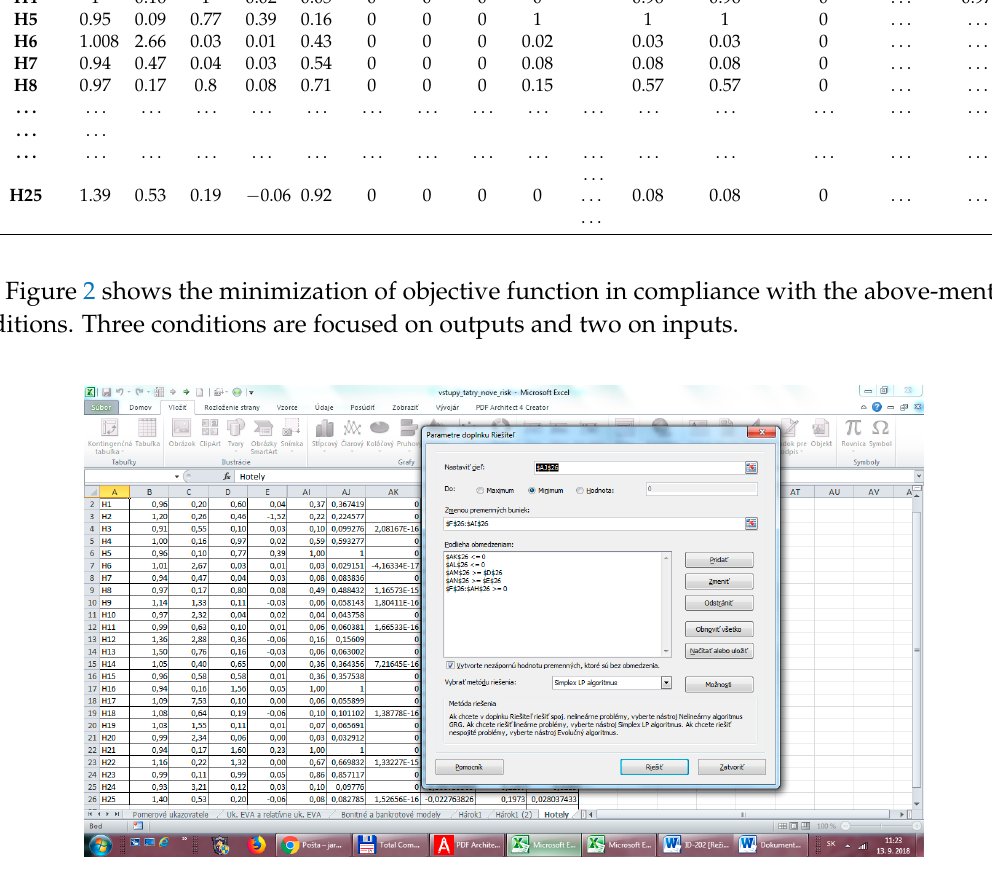
Figure 2. The example of inserting objective function and conditions in Solver.